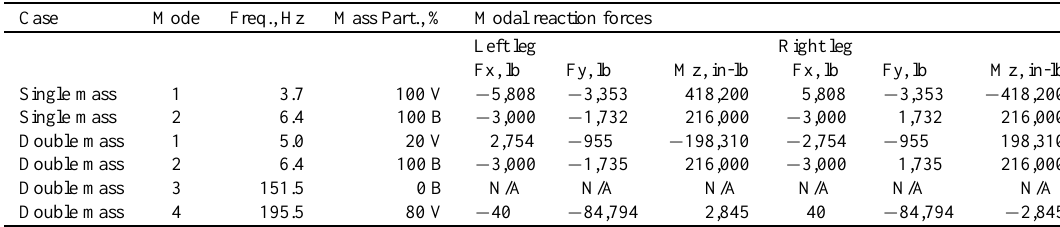
Fig. 10. Shock analysis models. Table 2 Shock analysis results for rod cases; Symmetric structure and